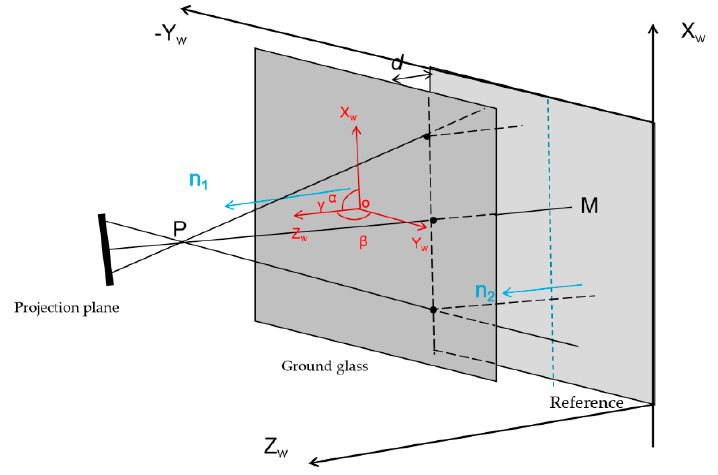
Figure 4. Schematic diagram of two - plane fitting.